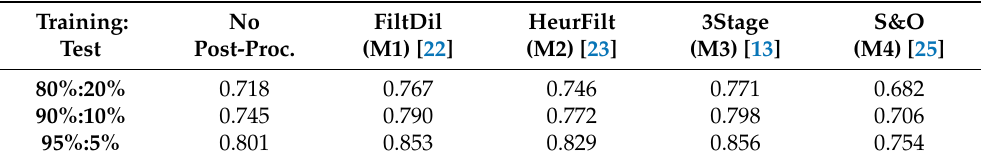
Table 7. Performance evaluation of accuracy metric on each of the four unvoted post-processing schemes associated with initial detection after updated two-stage learning (FC-DenseNet 103).